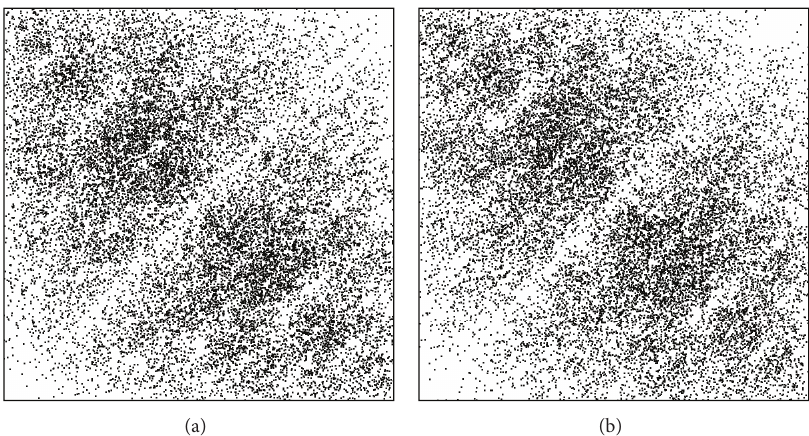
Figure 3: Two distributions generated with 20000 points and the same probabilities and factors ( 𝑝 1 = 0.29 , 𝑝 2 = 0.21 , 𝑝 3 = 0.29 , 𝑝 4 = 0.21 , = 0.7 , 𝑟 = 0.5 , 𝑟 = 0.7 , and 𝑟 = 0.5 ). 𝑟 1 2 3 4